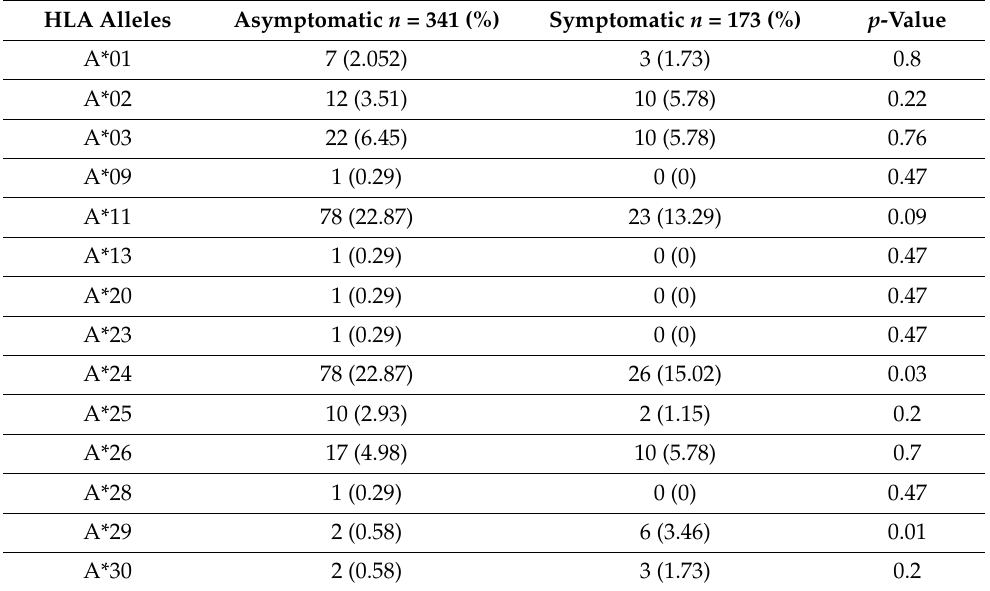
Table 2. HLA-A alleles frequency in RTRs with asymptomatic and symptomatic infection. HLA